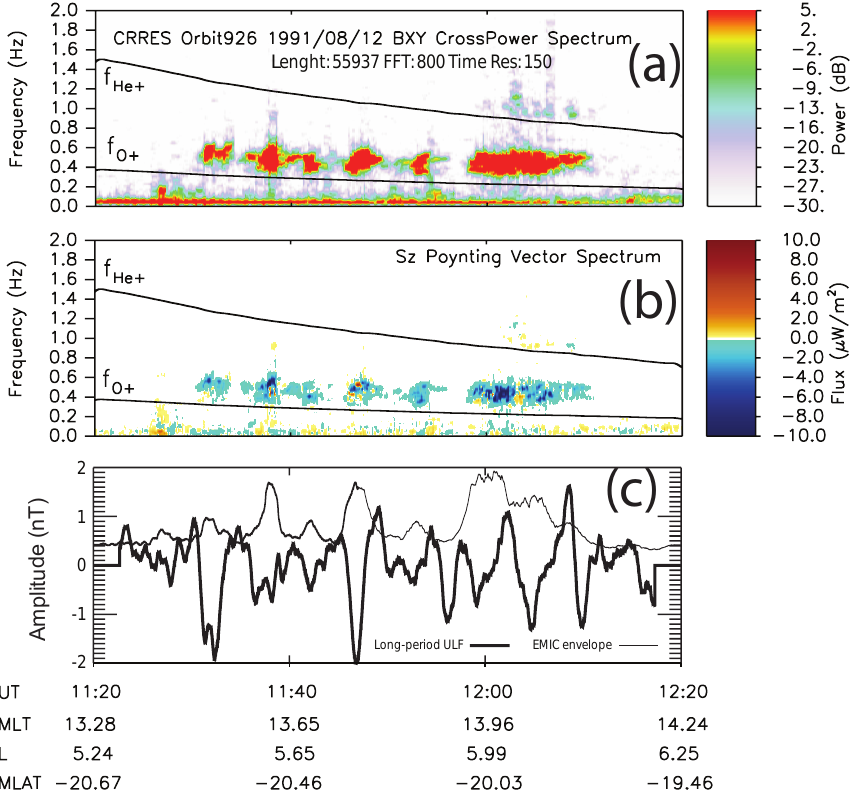
Fig. 1. Orbit 926, 12 August 1991 event. (a) transverse magnetic cross power, (b) field-aligned Poynting vector S z spectrogram and (c) the ULF magnetic compressional wave (thickline) and the EMIC wavepacket transverse magnetic amplitude envelope (thinline). The black lines in (a) and (b) represent the local He + ( f He + ) and O + ( f O + ) cyclotron